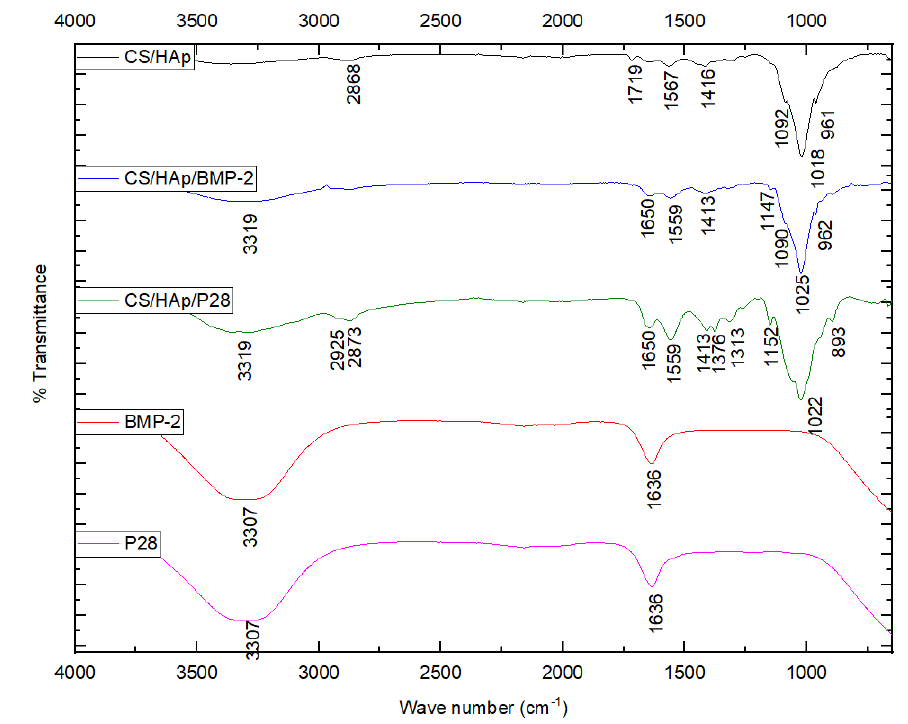
Figure 1. FTIR responses of the scaffolds, BMP-2 and P28, presenting the success of the covalent bonding through the increase in the peak height at 1650 cm − 1 .